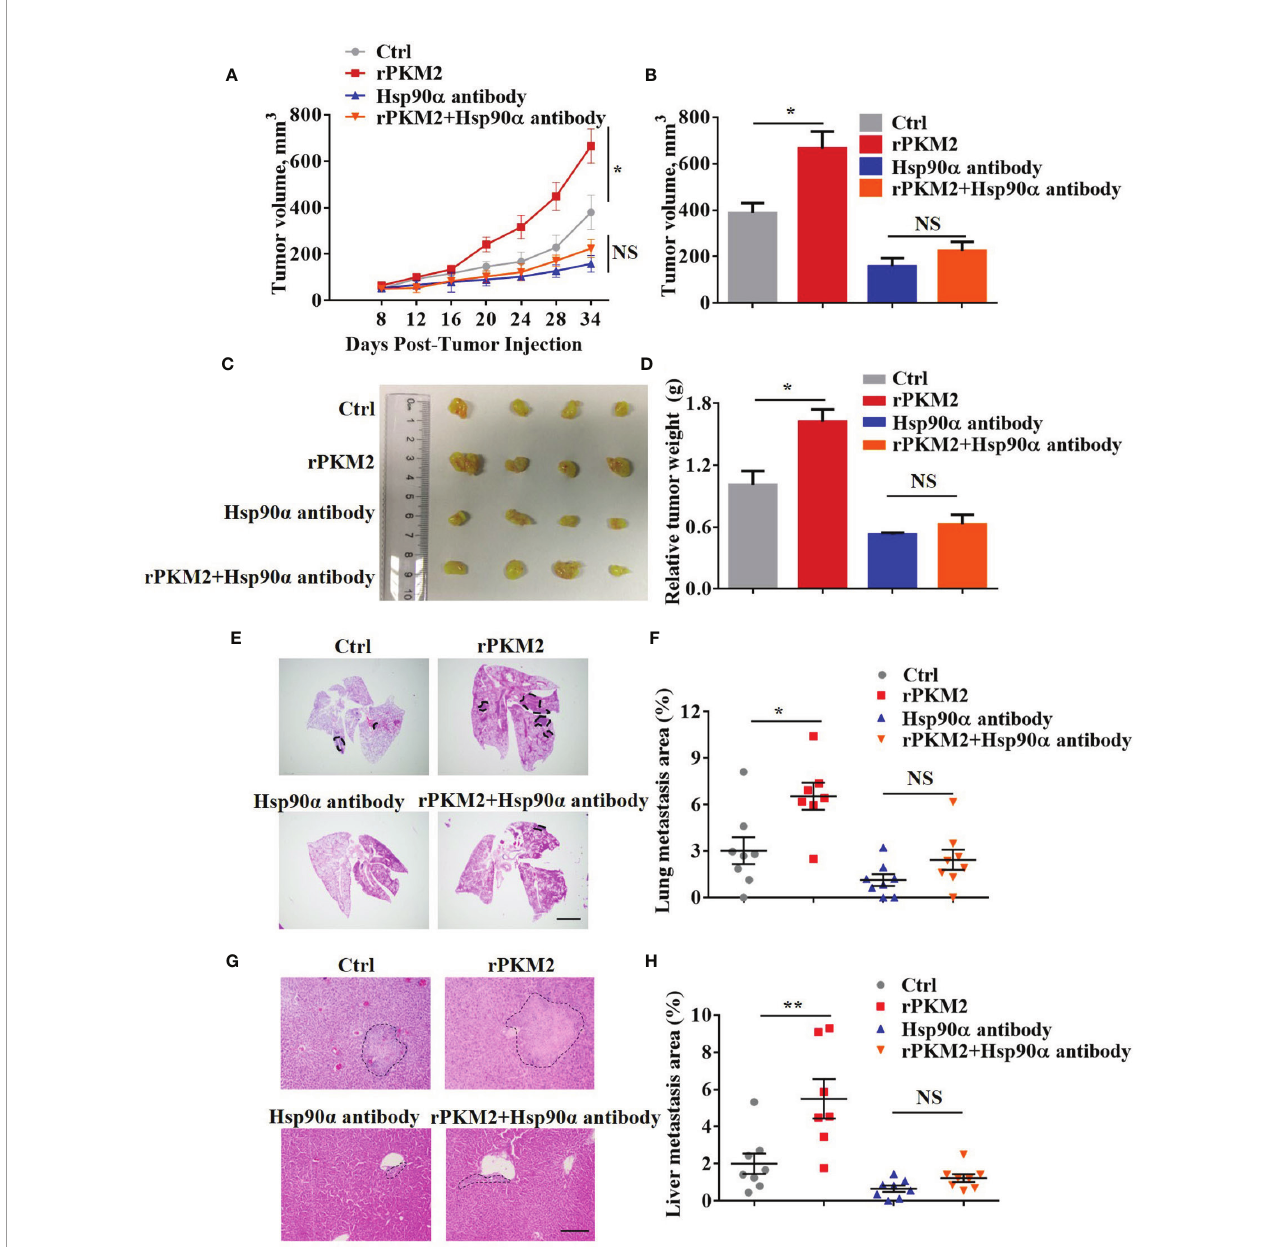
FIGURE 4 | Extracellular PKM2 promotes tumor progression dependent on extracellular Hsp90 a . (A – D) Tumor progression generated by subcutaneous injection of A549 cells into nude mice (n = 7 – 8/group). Mice were treated twice per week with PBS, rPKM2, anti-Hsp90 a , or anti-Hsp90 a and rPKM2 together by tail vein injection. (A) Tumor growth curves of A549 tumor xenografts. (B) Tumor volume at last time point. (C) The gross observation of tumors. (D) Tumor weight of A549 tumor xenografts. (E – H) Tumor metastasis generated by tail vein injection of A549 cells into nude mice (n = 7 – 8/group). Mice were treated twice per week with PBS, rPKM2, anti-Hsp90 a , or anti-Hsp90 a and rPKM2 together by tail vein injection. (E) Representative H&E images of lung metastasis areas. Scale bars, 2 mm. (F) The quali fi cation of lung metastasis areas. (G) Representative H&E images of liver metastasis areas. Scale bars, 200 m m. (H) The quali fi cation of liver metastasis areas. Scale bars, 200 m m. Data are represented as mean ± SEM. NS, not signi fi cant; * p < 0.05 and ** p < 0.01, longitudinal models for analyzing the repeated measures of tumor volume (A) or two-tailed Student ’ s t tests (B, D, F, H)